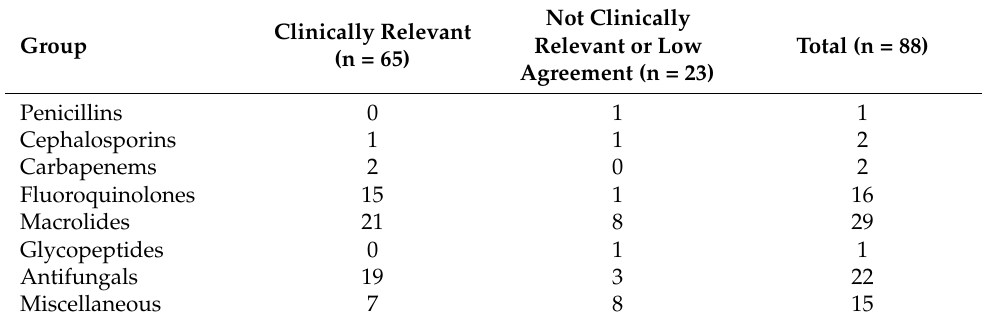
Table 1. Ratings of the expert panel.